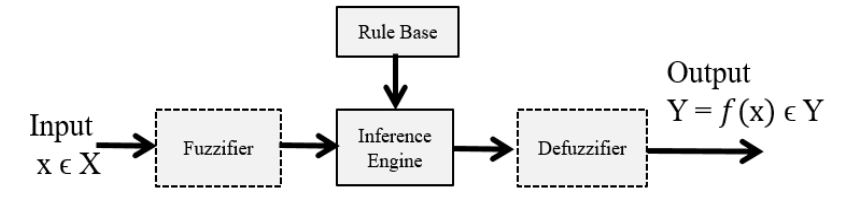
Figure 1. Architecture of a type-1 fuzzy logic system.